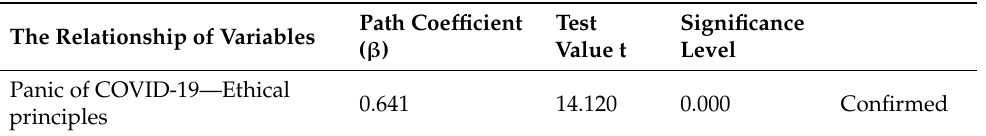
Table 10. Evaluation indicators of the internal model of the research, direction and significance of direct